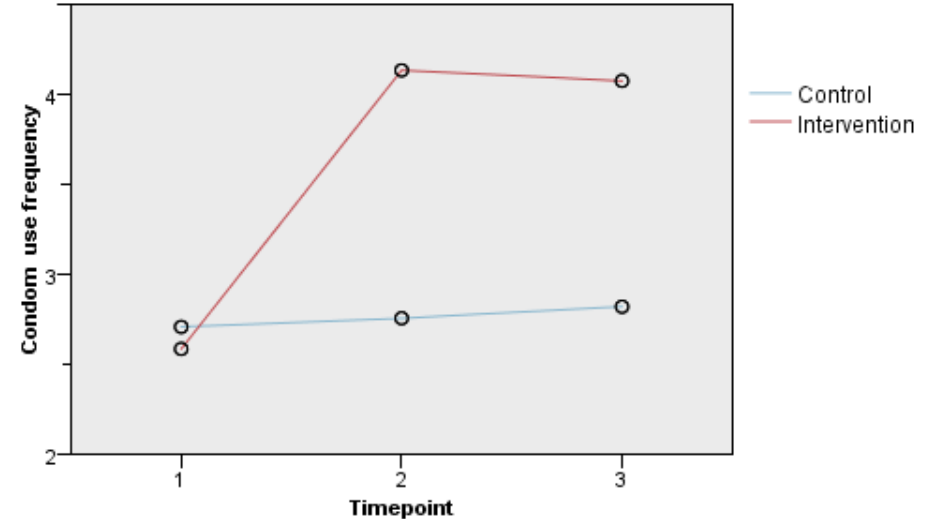
Using generalised linear mixed model adjusted for covariates with multiple imputated data. * Significant at p ≤ 0.05.